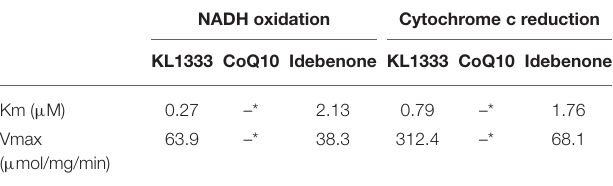
TABLE 1 | Steady-state kinetic constants of NQO1 with KL1333, CoQ10, and